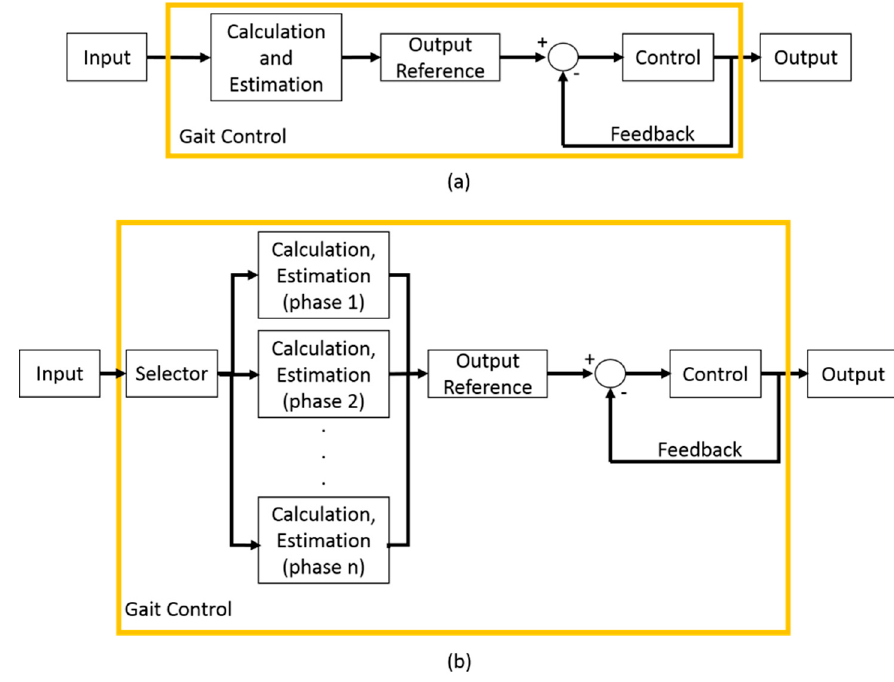
Figure 2. Gait control strategy framework: ( a ) Subject-oriented; ( b ) Phase-oriented.